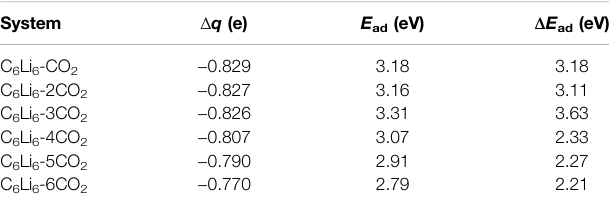
TABLE 2 | ω B97xD/6-311+G (d) calculated NBO charge on CO 2 ( Δ q ), adsorption energy per CO 2 ( E ad ), and consecutive adsorption energy ( Δ E ad ) for C 6 Li 6 - n CO 2 complexes taken from Ref.